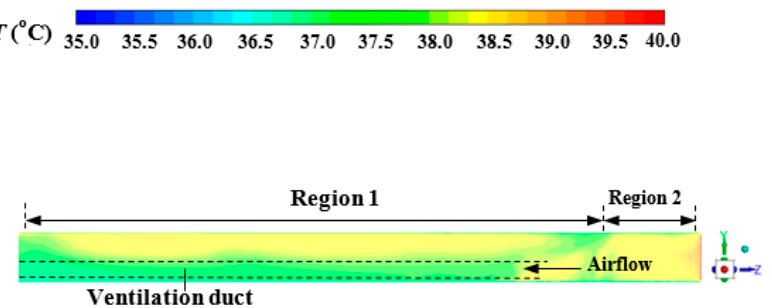
Figure 8. Temperature distribution of airflow in the cooling region for the heading face cooled only by exhaust ventilation.